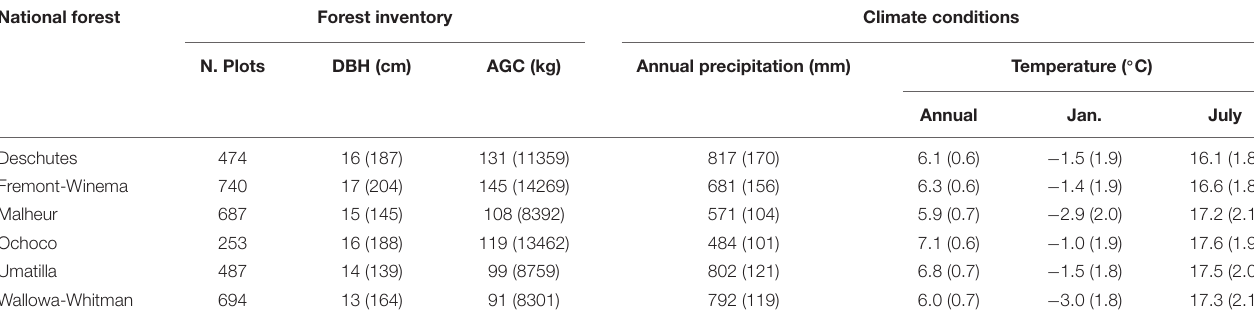
TABLE 1 | Summary of forest inventory data and climate conditions for the six National Forests included in the analysis. National forest Forest inventory Climate conditions N.